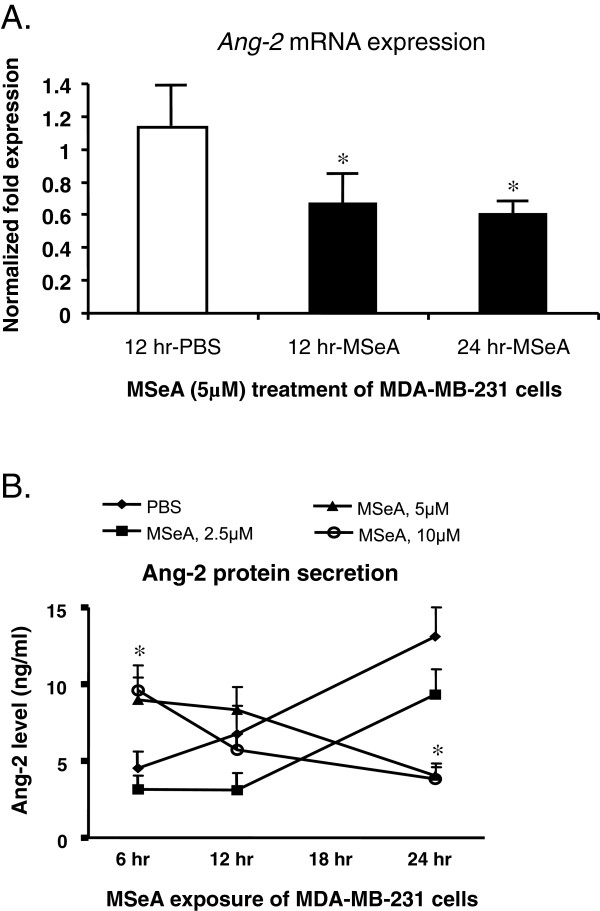
Inhibition of Ang-2 mRNA transcripts and Ang-2 protein secretion in cultured mammary cancer cells by the MSeA treatment. MDA-MB-231 cells were treated with selected concentrations of MSeA at the designated time intervals. Cellular mRNA and total protein from MSeA treated cells were isolated for subsequent quantitative analysis. A. Compared with the PBS controls, levels of Ang-2 mRNA in MDA-MB-231 cancer cells were significantly reduced 12 hrs following the MSeA (5 μM) treatment, determined by quantitative RT-PCR (p < 0.05). MSeA treatment of the cells for 24 hrs did not further inhibit Ang-2 mRNA expression. B. Secretion of Ang-2 protein into the medium by the MDA-MB-231 cells were significantly inhibited (p < 0.05) 24 hrs following the MSeA treatment at concentrations 5 μM or higher, as determined by Radioimmunoassay (RCA). Compared with the PBS control, a brief but significant increase in Ang-2 protein secretion was observed for the MDA-MB-231 cells at 6 hrs following the 5 μM and 10 μM MSeA treatments, and the reason is currently unknown to us.